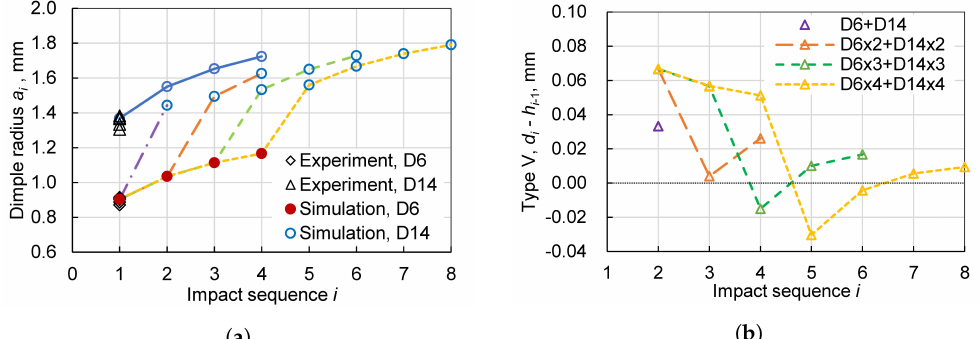
Figure 5. ( a ) Dimple radius and ( b ) difference between indenting depth of hammering tool and original dimple depth.